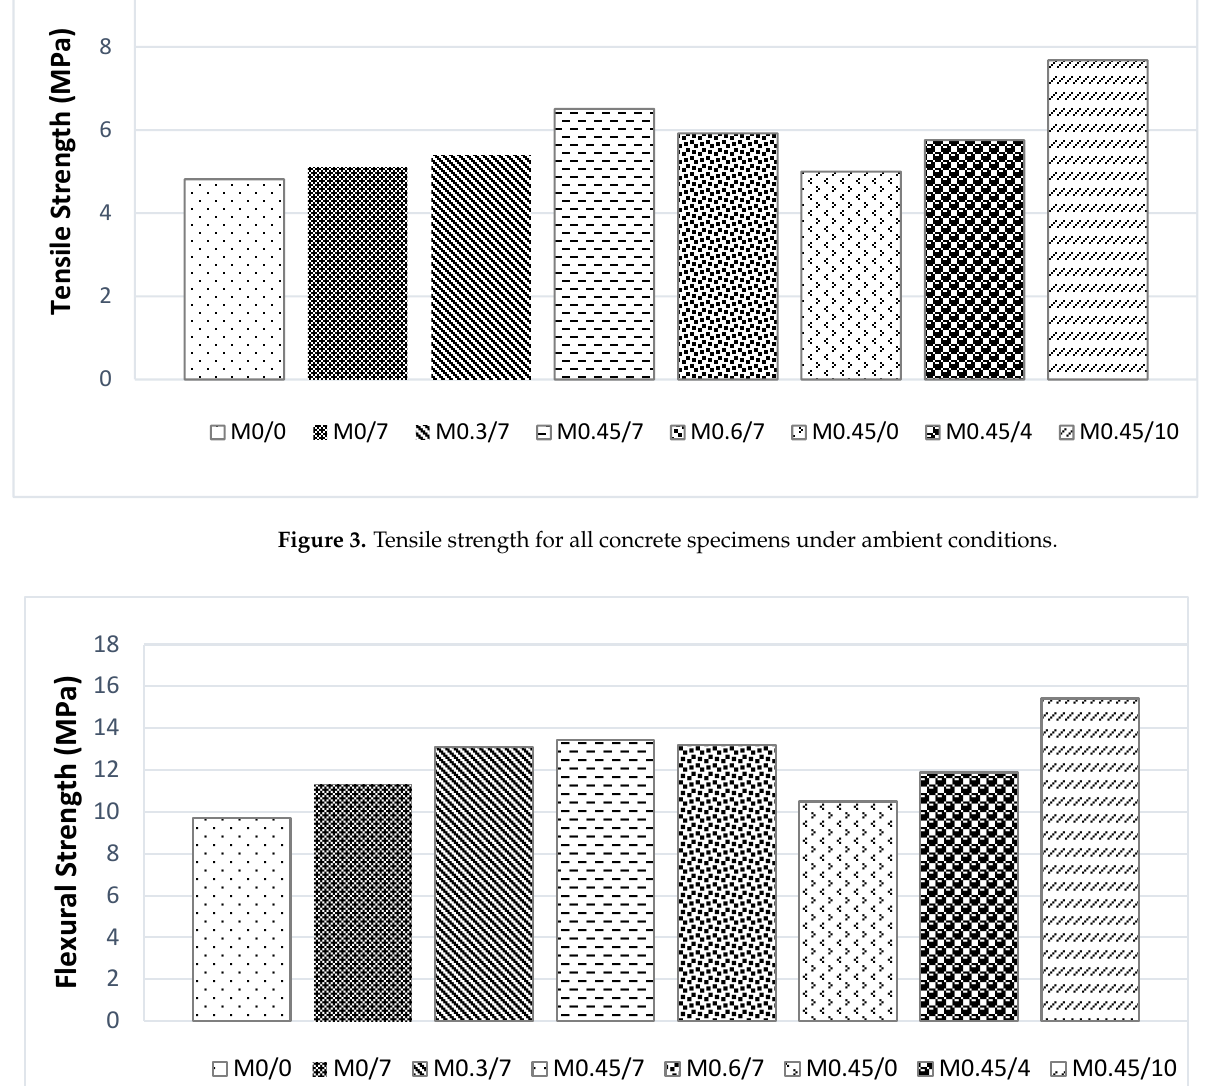
Figure 4. Flexural strength for all concrete specimens under ambient conditions.